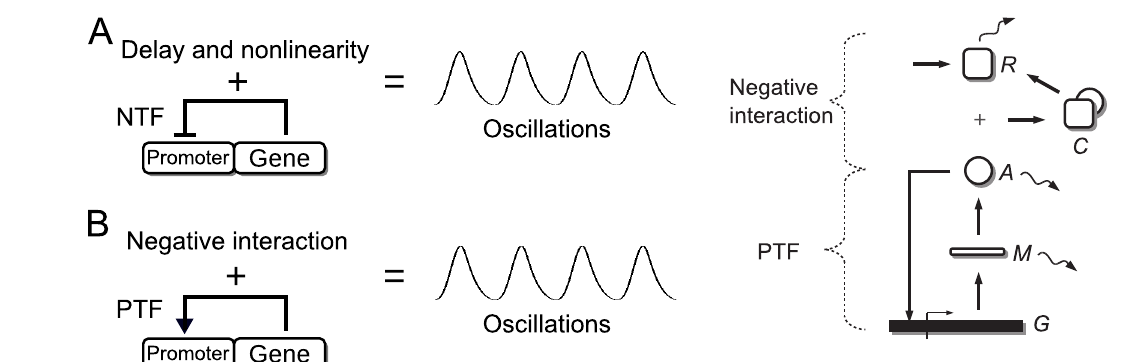
Figure 2. Model of a one-gene oscillator with PTF. The model is composed of two well-differentiated parts. The first part is a positive feedback loop in which a gene ( G ) is transcribed into mRNA ( M ). In turn, M is translated into protein ( A ). This protein is a transcription factor of its own gene and increases the transcription rate when it binds to the promoter. The positive feedback needs a second part, consisting of a negative interaction in order to obtain reliable oscillations. In this part repressor molecules ( R ) enter the system at a constant rate. R inhibits the function of A . Specifically, R binds to A and forms the complex C . In this complex, A is not able to bind to its promoter. R is not degraded together with A and can be used several times. Therefore, R can be thought of as a protease, a protein that sequesters A or any other molecule that binds to and inhibits the function of A as explained above. The zigzag arrows stand for degradations. A different version of the model can be formulated with the negative interaction acting over M instead of over A .